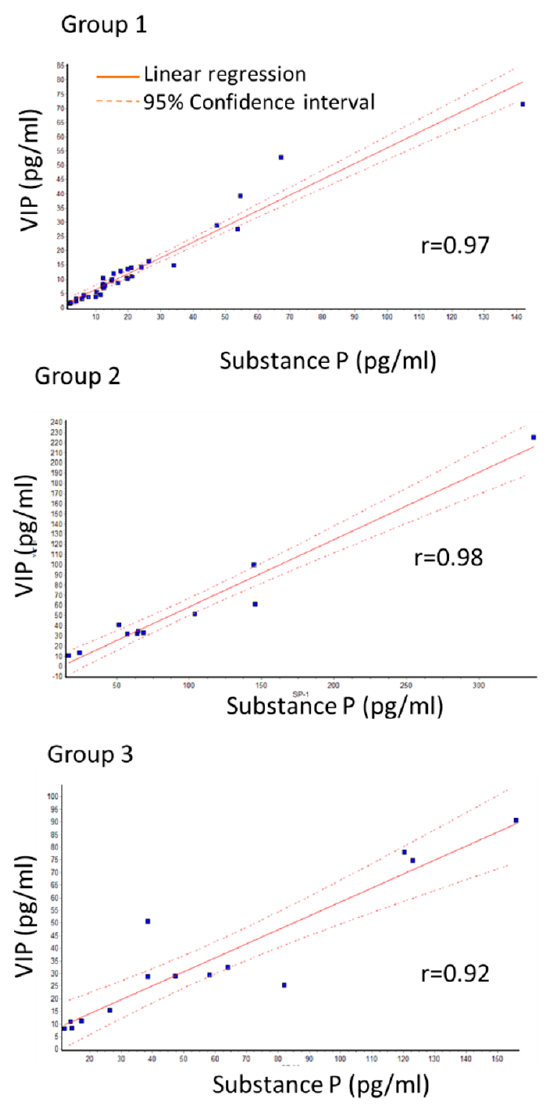
Figure 1. Correlation between SP and VIP levels in primary group (group 1) with no recurrence, recurrence of primary group (group 2) and group that had recurrence surgery (group 3). r shows Pearson correlation coefficient. Close correlation is seen in all